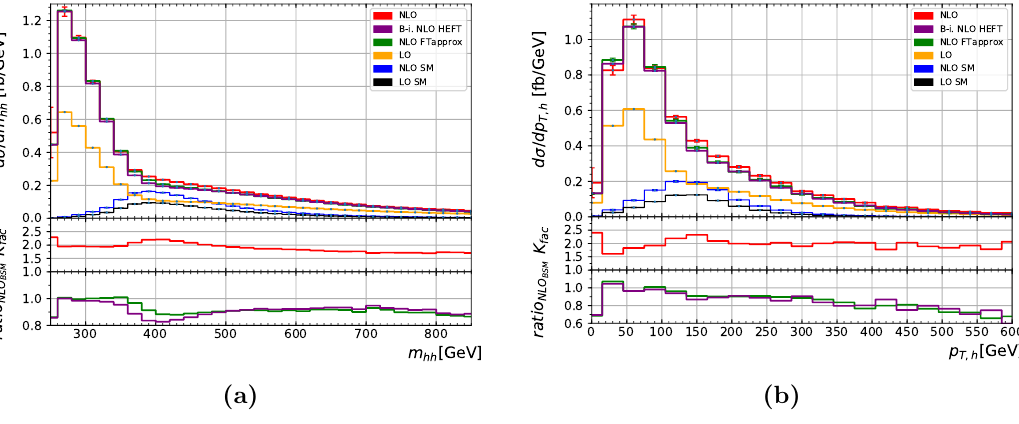
Figure 23. Same as (cid:12)gure 12 but for benchmark point 11, c hhh = 2 : 4 ; c t = 1 ; c tt = 0 ; c ggh = 2 = 3 ; c gghh = 1 =